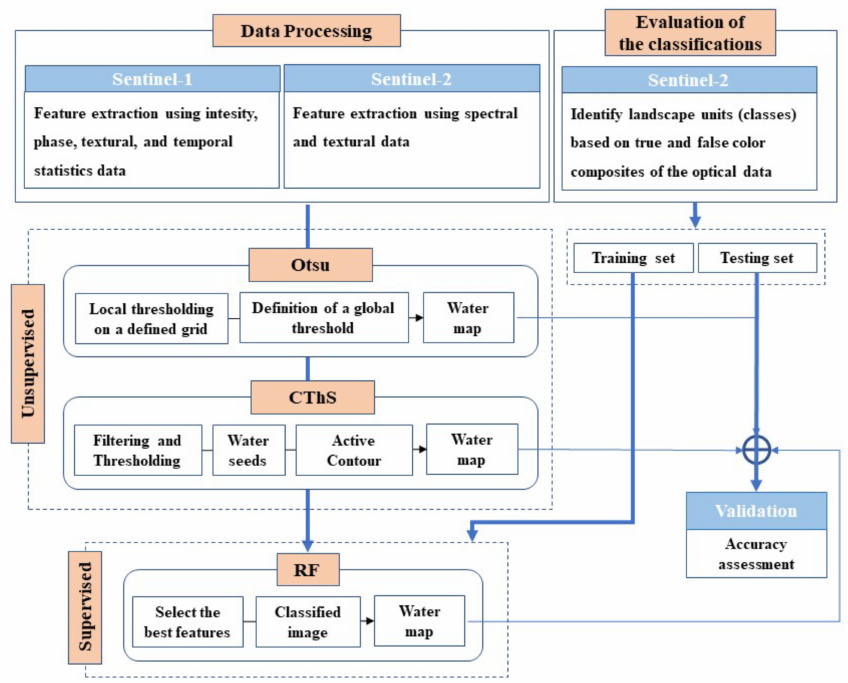
Figure 2. The work-flow of the approach, consisting of three different